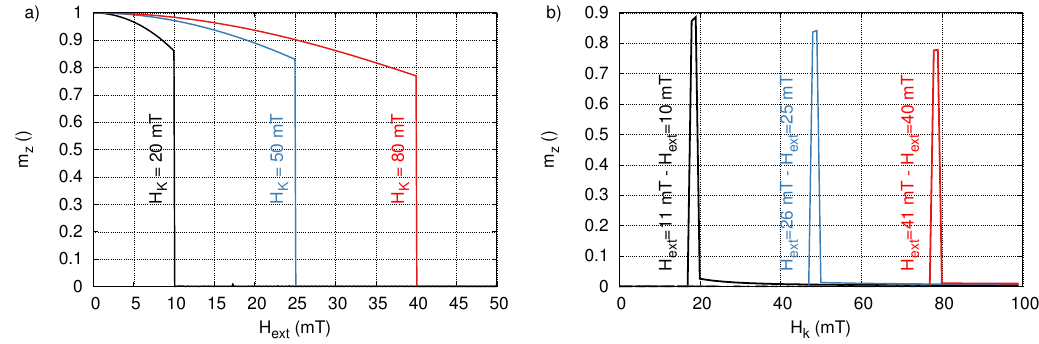
Figure 6. ( a ) The z-component of the magnetization as function of externally applied rotating field amplitude for particles with 3 different anisotropy fields, corresponding to 3 cross sections of Figure 5b (indicated with lines in the same color). ( b ) Three examples of the difference between two subsequent excitations with pulse amplitudes spaced 1 mT apart. This shows that it is possible to excite a very narrow subset of the particles with a specific H K , and thus a specific coercivive field of H K